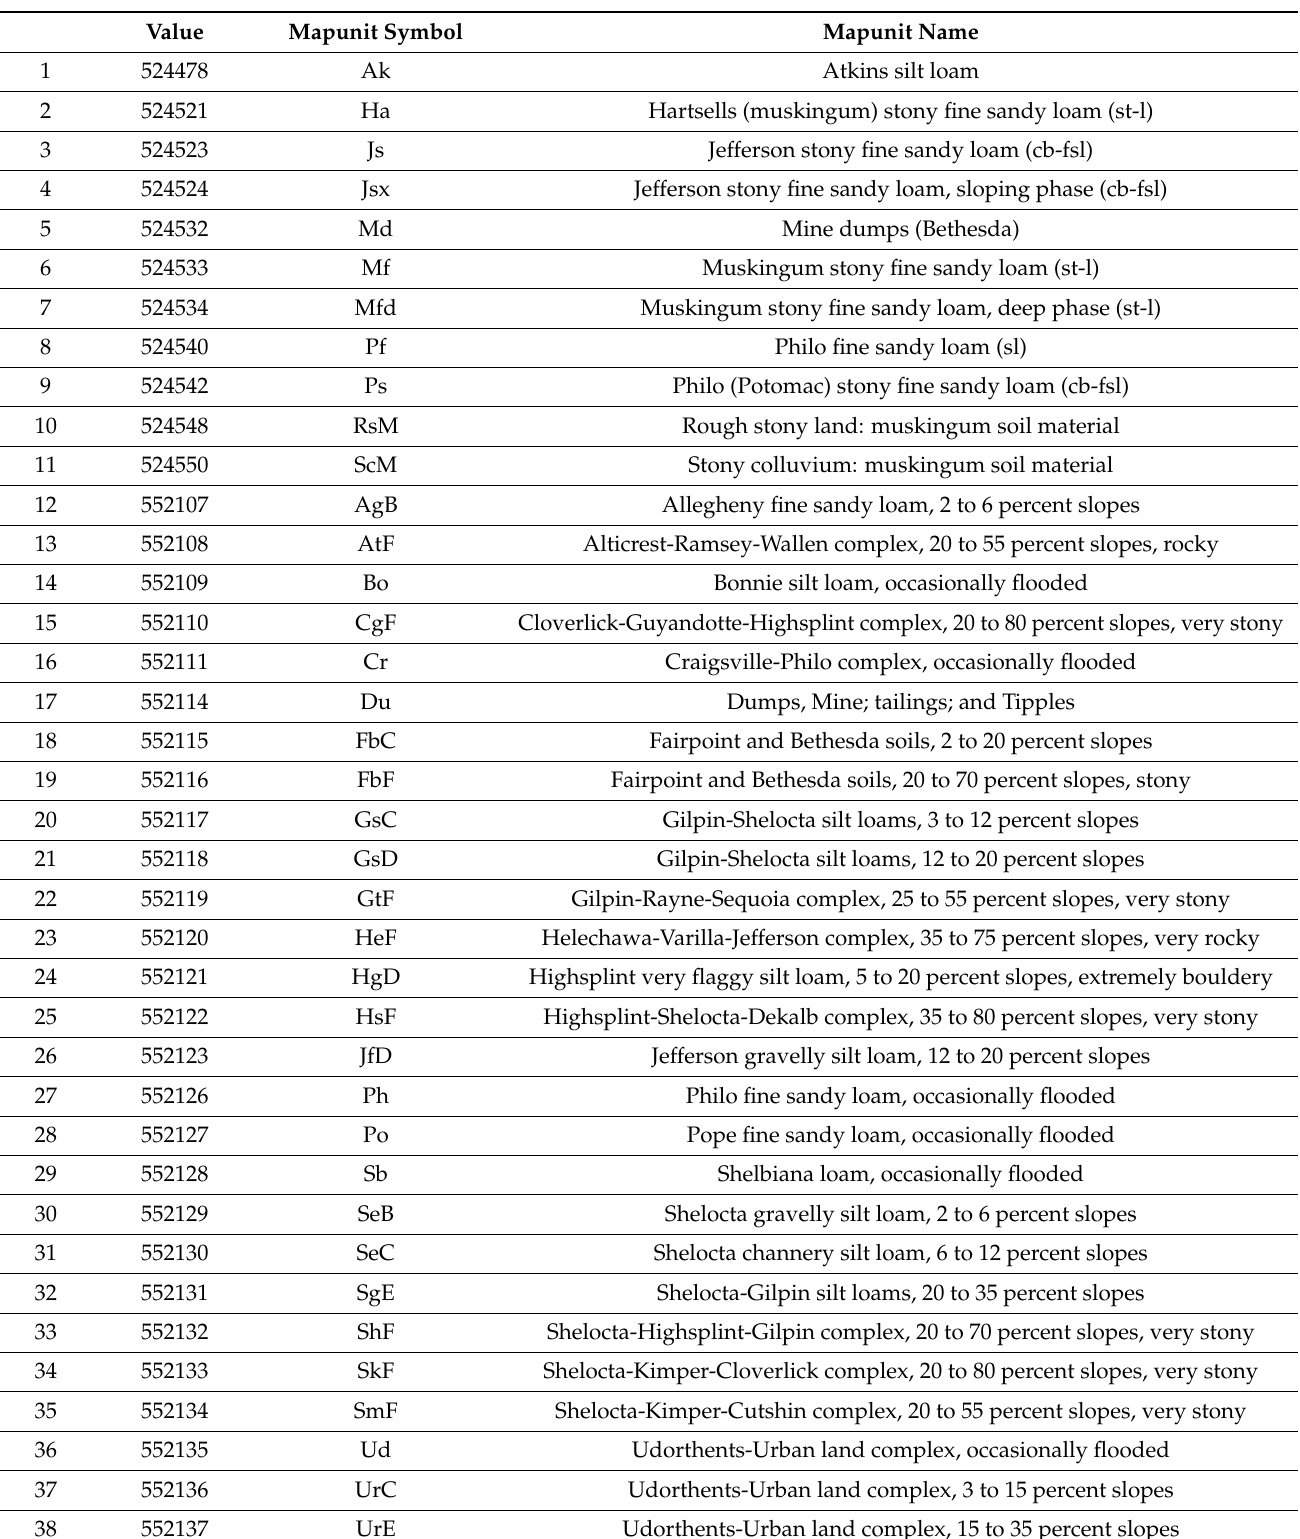
Table A1. SSURGO soil class